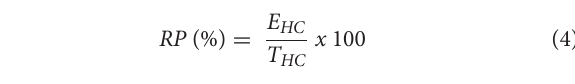
theoretical H 2 consumption (T HC